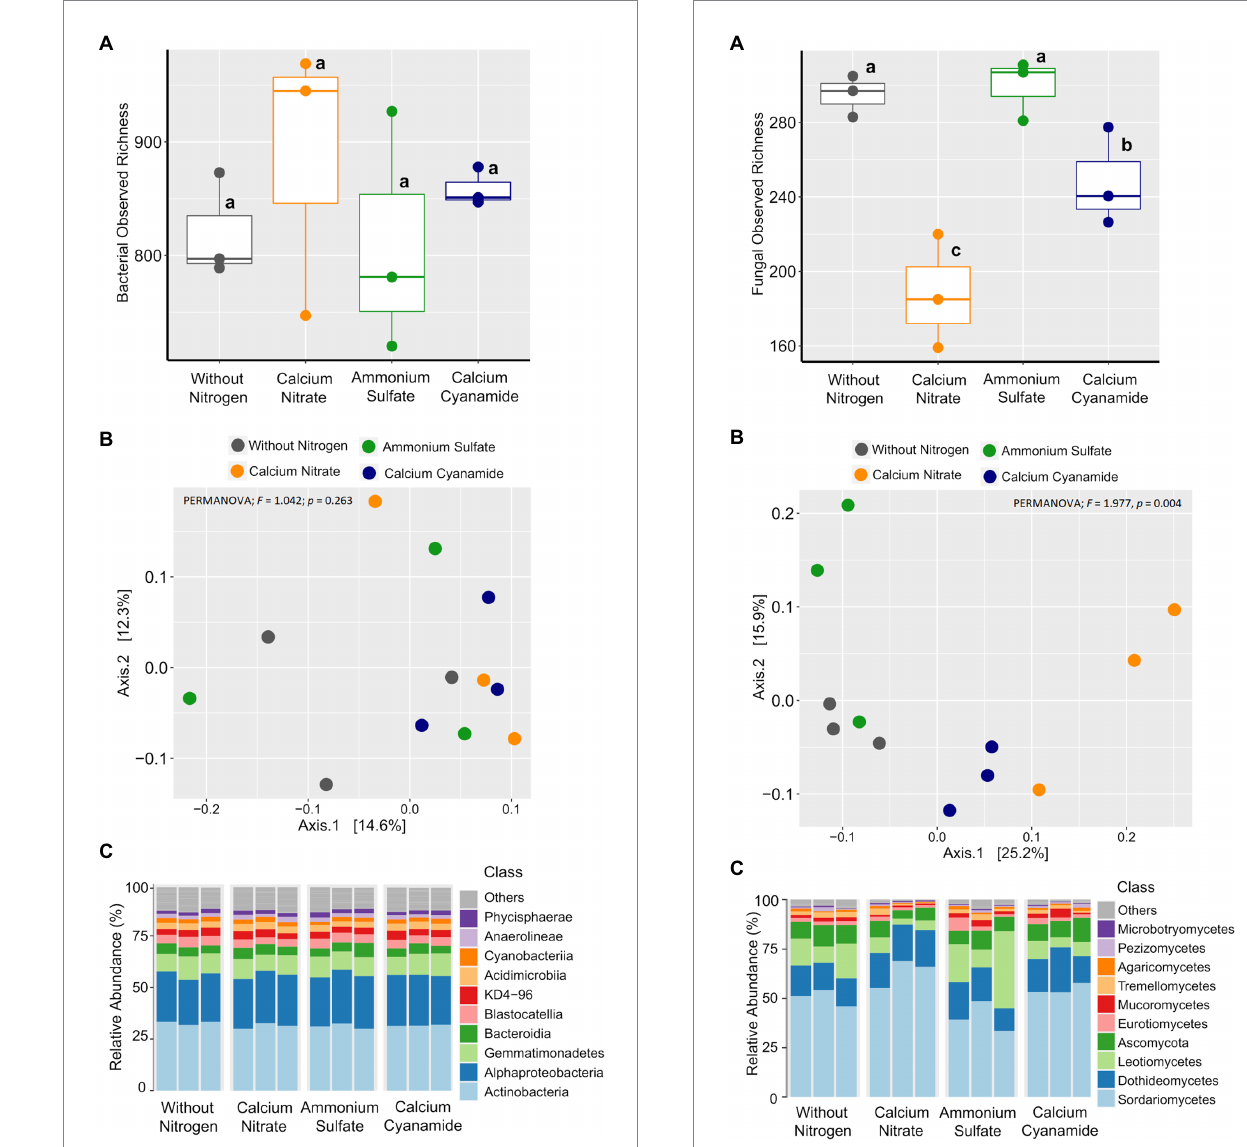
FIGURE 5 Box plots of the bacterial observed richness. (A) Principal coordinates analysis (PCoA) based on Bray–Curtis dissimilarity. (B) Colors: without nitrogen, black; calcium nitrate, orange; ammonium sulfate, green; calcium cyanamide, blue. Effects of N fertilization were tested with PERMANOVA (based on Hellinger transformed data and the Bray–Curtis distance measure). (C) Mean relative abundance of the main classes of the bacterial communities detected. The same lowercase letters indicate no significant differences at 0.05 probability level according to Tukey multiple comparison test.